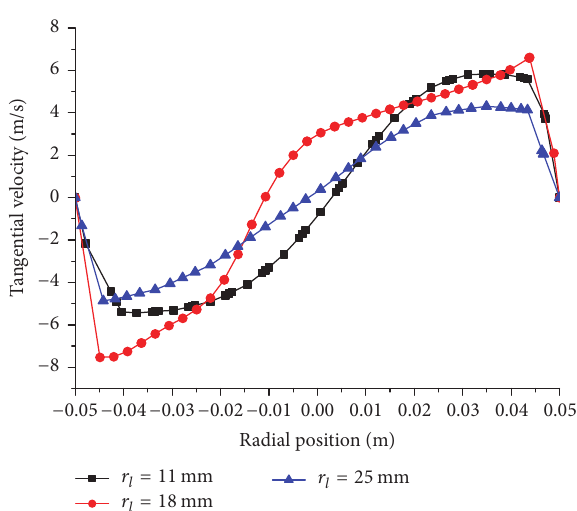
Figure 11: Tangential velocity distribution on the cross section of the separator middle position.